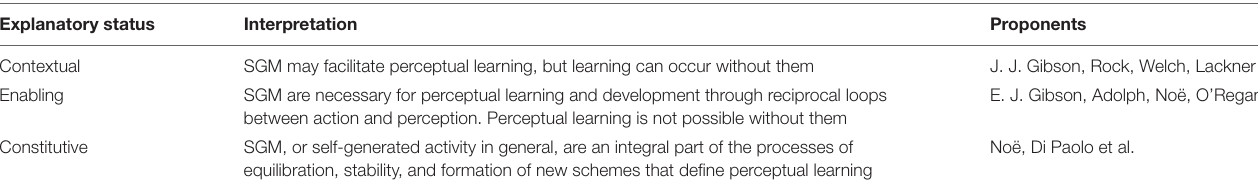
TABLE 1 | Summary of the different responses to Held’s proposal concerning the causal status of self-generated movements (SGM) for sensory adaptation and perceptual learning. Explanatory